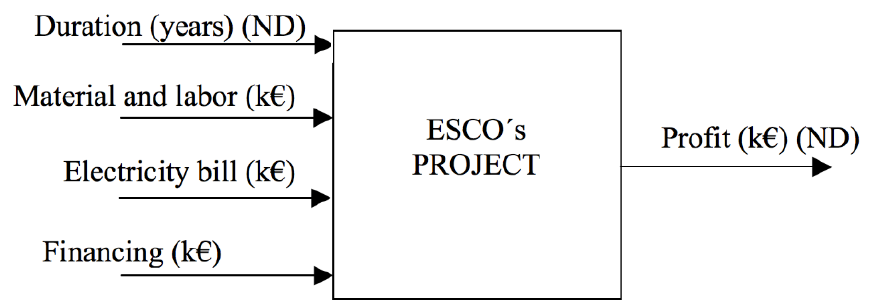
Figure 2. The e nergy service company (ESCO) project selection problem. Figure 2. The energy service company (ESCO) project selection